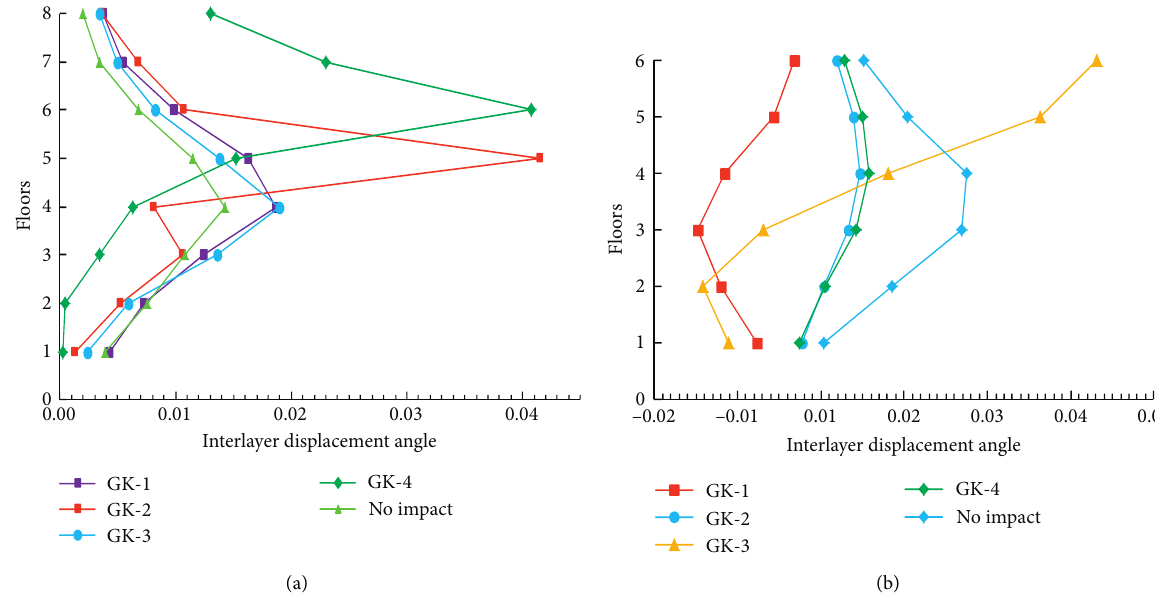
Figure 7: Interlayer displacement angle of adjacent frames (PGA � 0.40g): (a) KJ-A and (b)